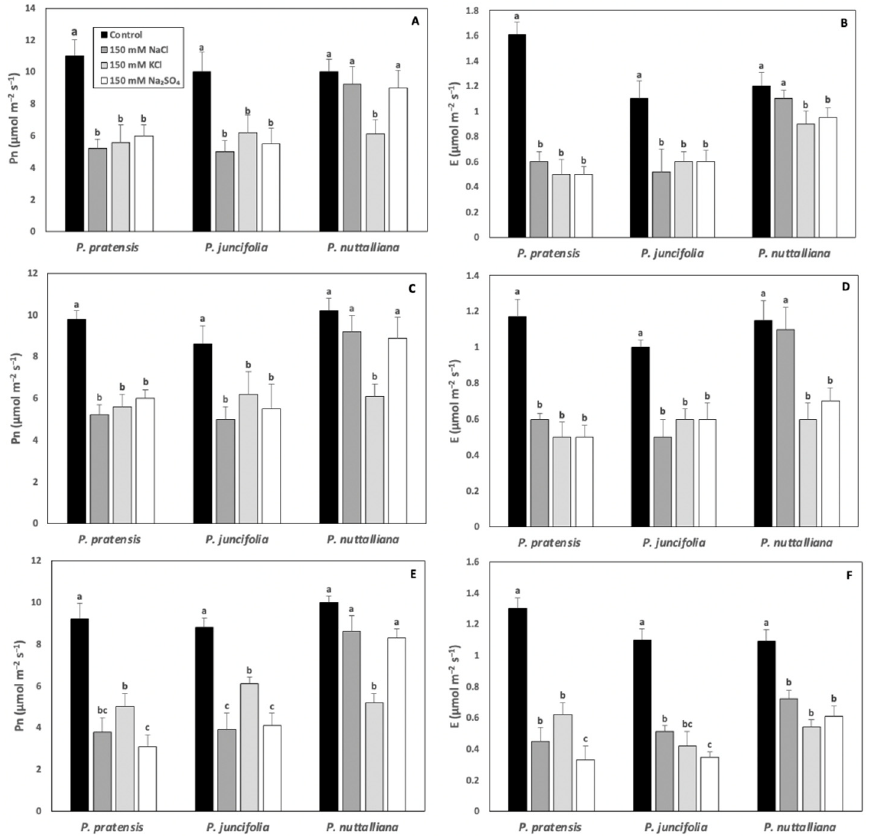
Figure 2. Net photosynthesis (Pn) ( A , C , E ) and transpiration ( E ). ( B , D , F ) rates in Poa pratensis , Poa juncifolia , and Puccinellia nuttalliana after three ( A , B ), six ( C , D ) and nine ( E , F ) days of treatments with 150 mM NaCl, 150 mM Na 2 SO 4 , 150 mM KCl, and in untreated control plants. Different letters above the bars indicate significant differences ( p ≤ 0.05) between treatments within each species as determined by the Tukey’s test. Means ( n = 6) and SE are shown.